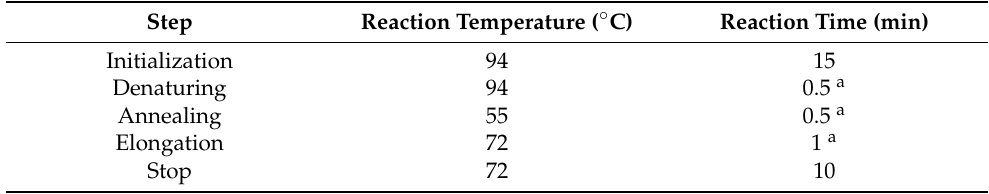
Table 1. Actinomycete 16S rRNA amplification PCR protocol. Step Reaction Temperature ( ◦ C) Reaction Time